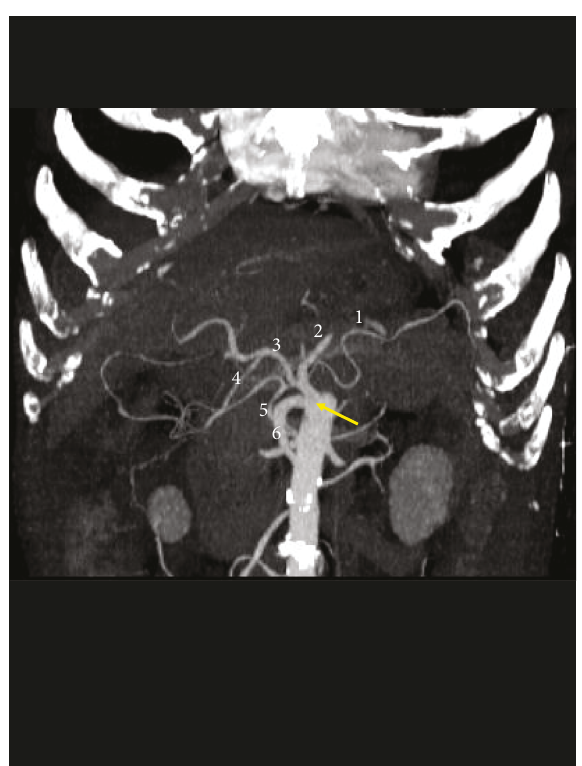
Figure 3: Three-dimensional volume rendering CTimage showing a complete celiacomesenteric trunk (CMT) inclusive of mesenteric (M) and celiac (C) ramifications.